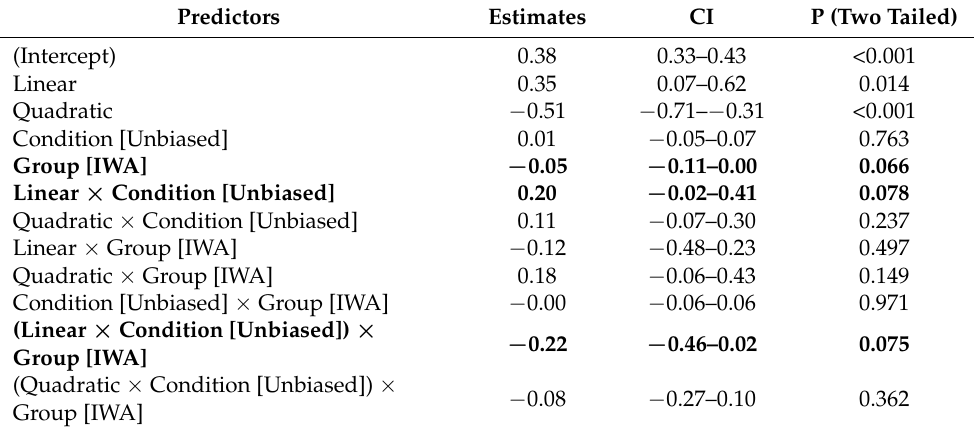
Table 5. Results of GCA analysis for time window 2 (processing